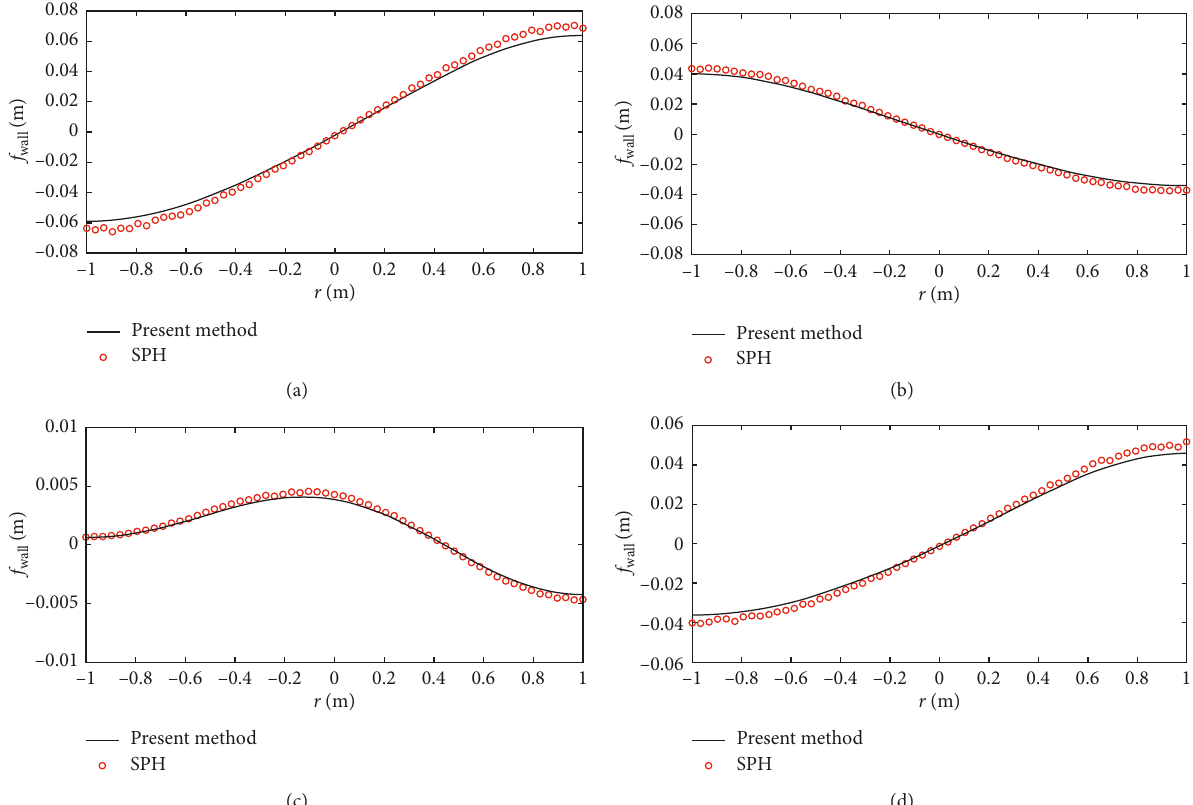
Figure 9: Surface wave profiles across the container at different times for ω � 6.28rad/s. (a) t � 0 . 5 s. (b) t � 1 . 5 s. (c) t � 2 . 5 s. (d) t � 3 . 5 s.